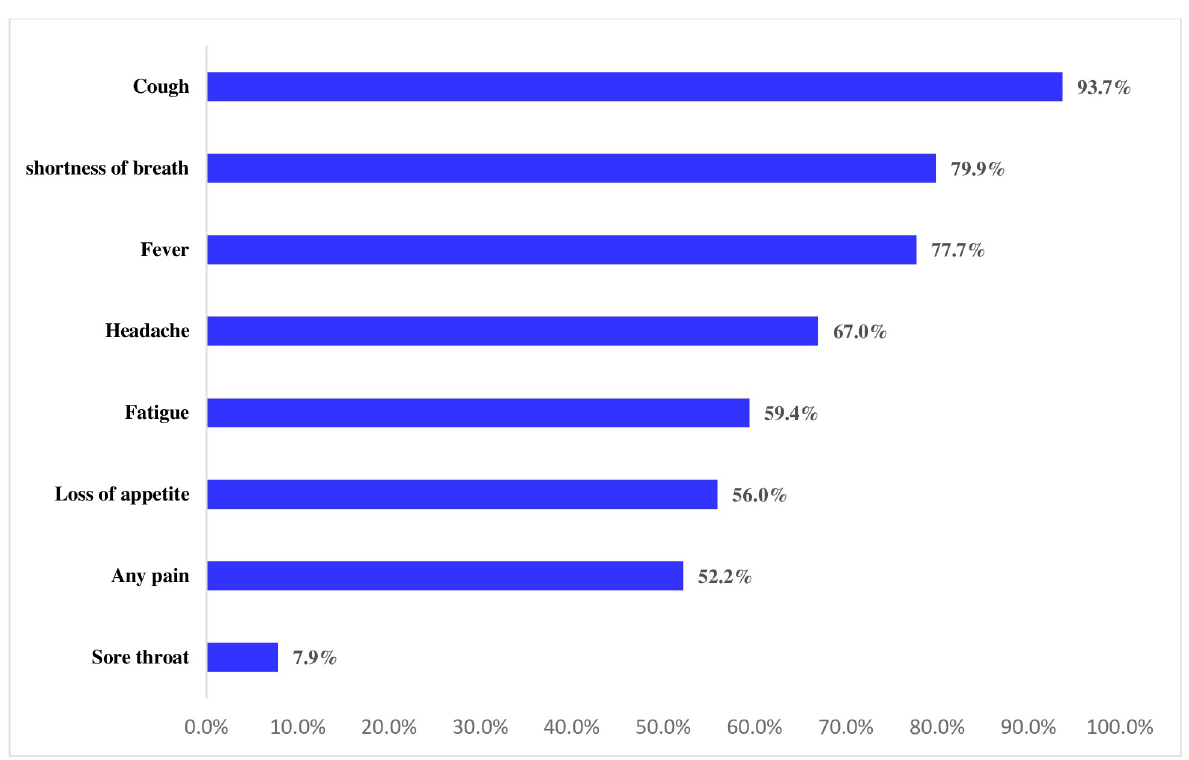
Fig 1. Sign and symptoms reported among severe COVID-19 patients admitted at WURH,